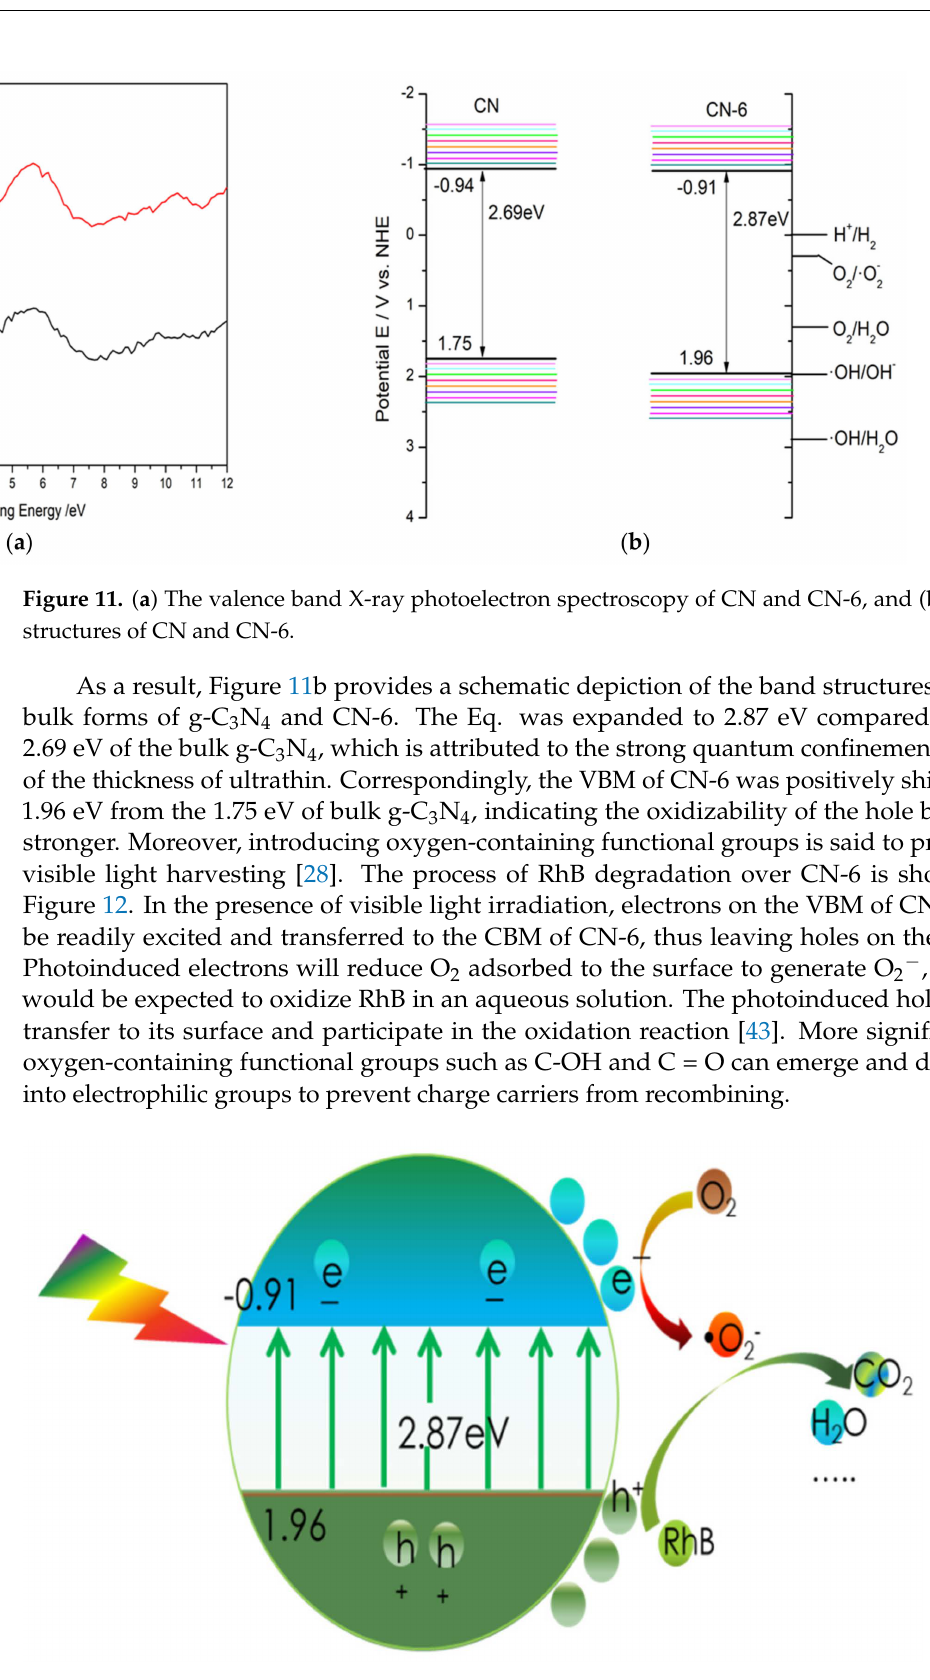
Figure 12. The process of RhB degradation over